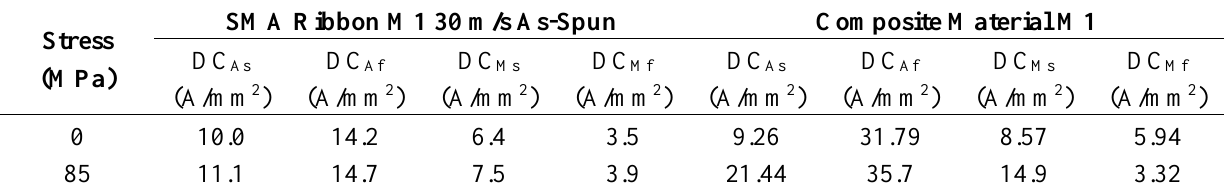
Figure 7. Curves of current density versus strain for the: ( a ) NiTi ribbon, ( b ) smart composite material. Table 3. Current density (A/mm 2 ) at the phase transformations of the NiTi ribbon and the composite material applying 0 MPa and 85